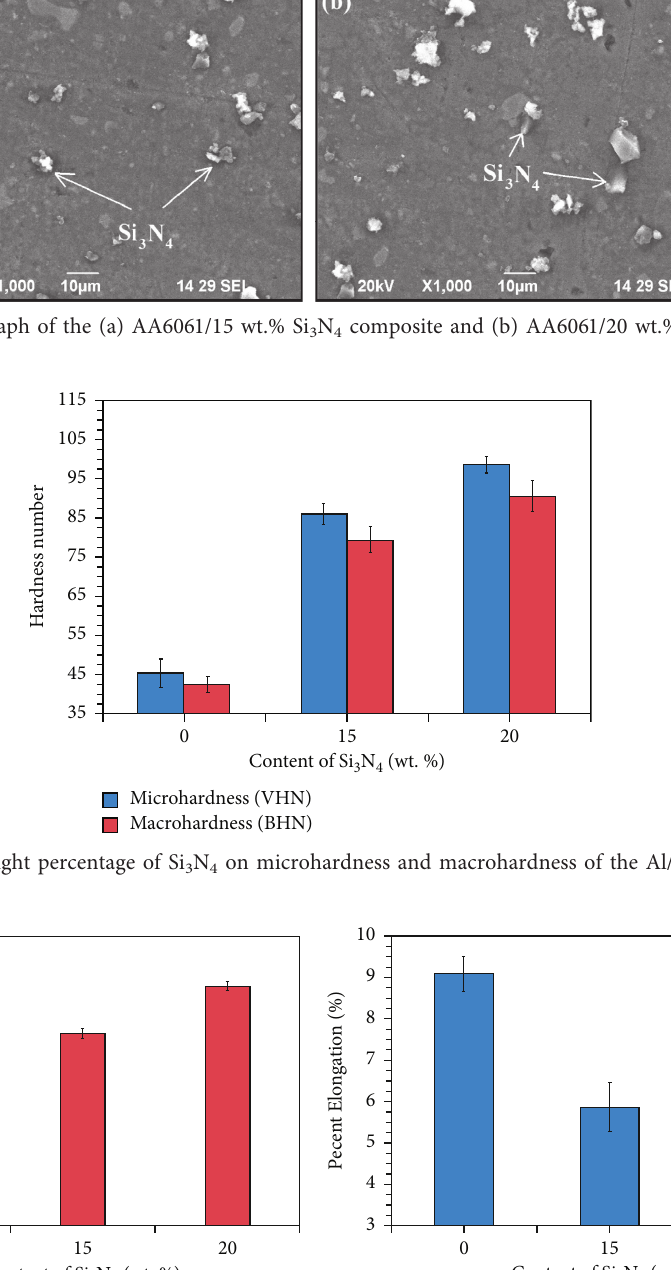
Figure 9: Effect of weight percentage of Si 3 N 4 on (a) UTS and (b) PE of the AA6061/Si 3 N 4 composite.